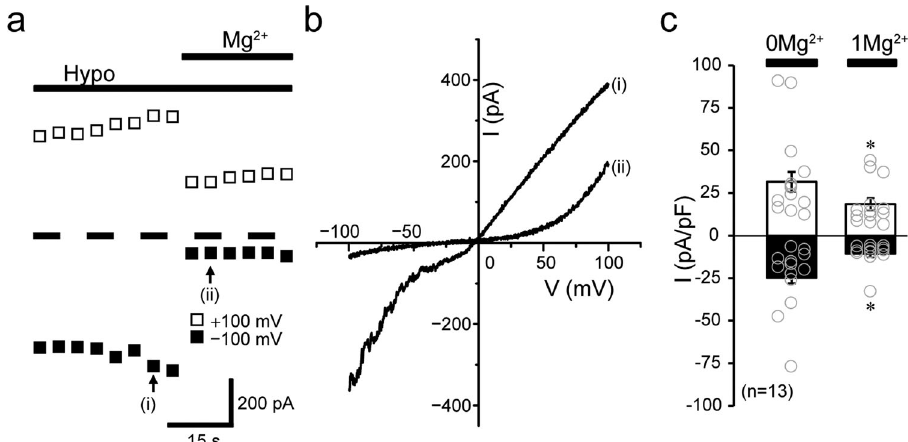
Fig. 5 Mg 2 + sensitivity of TRPM7 currents in DT40 cells. a Representative recording showing the time course of whole-cell currents recorded at + 100 and − 100 mV during hypotonic stimulation in the cells before and after extracellular application of 1 mM Mg 2 + ( Mg 2 + ). Currents were elicited by ramp- clamp (every 5 s at 4 mV/ms). Bars above the recording indicate the time during applications of hypotonic solution ( Hypo ) and Mg 2 + . b Representative I – V relationships of currents in response to ramp pulses from − 100 to + 100 mV before (at i in a ) and during application of Mg 2 + (at ii in a ). c Peak current densities at + 100 (blank columns) and – 100 mV ( fi lled columns) before ( 0Mg 2 + ) and after application of 1 mM Mg 2 + ( 1Mg 2 + ) ( n = 13). Each data point represents the mean ± SEM (vertical bar) of n samples. * P ( = 0.048 and 0.021 at + 100 and − 100 mV, respectively) <0.05 compared to corresponding data in 0Mg 2 + group by t -test.